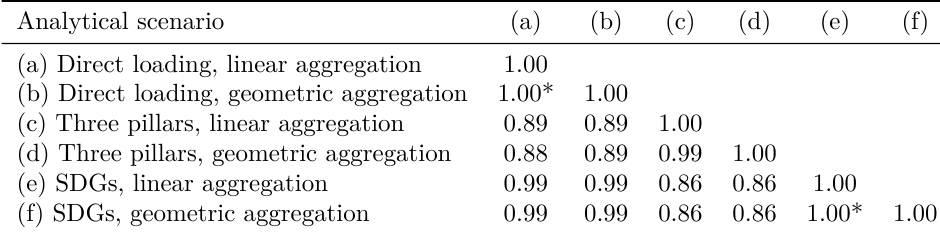
Table 5. Correlation coe ffi cients for sustainability scores between analytical